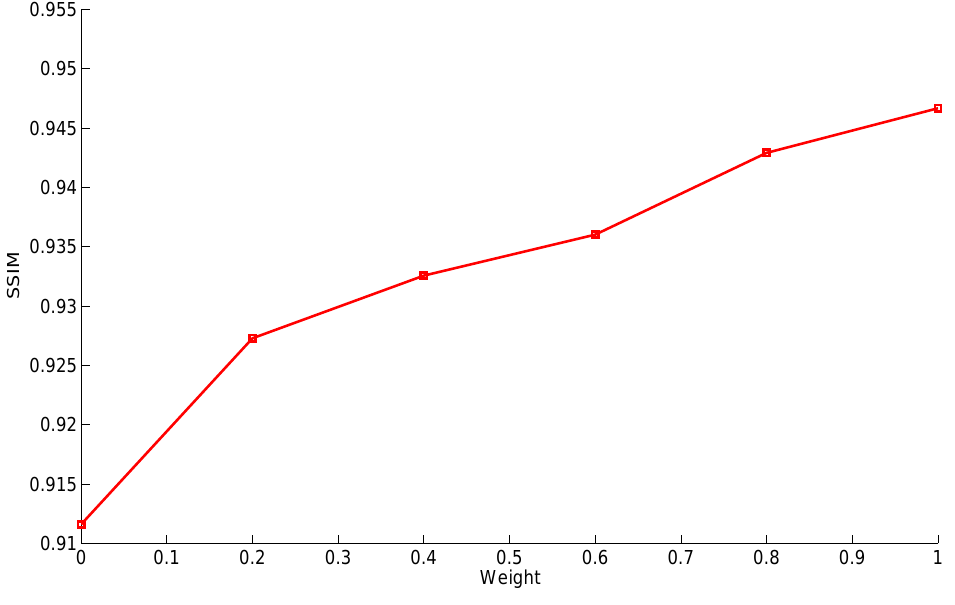
Figure 8. The curve of quantitative qualities of seamlines detected by using different